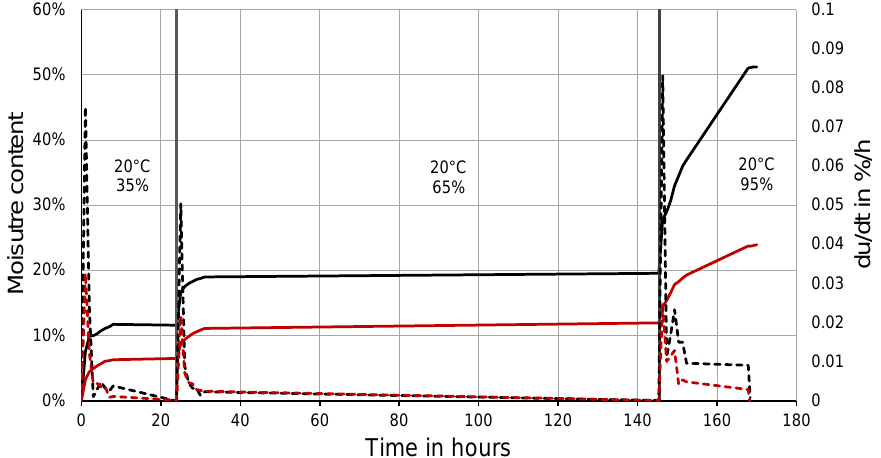
Figure 3. Hygroscopic response of peat moss and saw dust to different climates with sorption rates of the moss and wood saw dust (du/dt = relative moisture uptake per time unit).